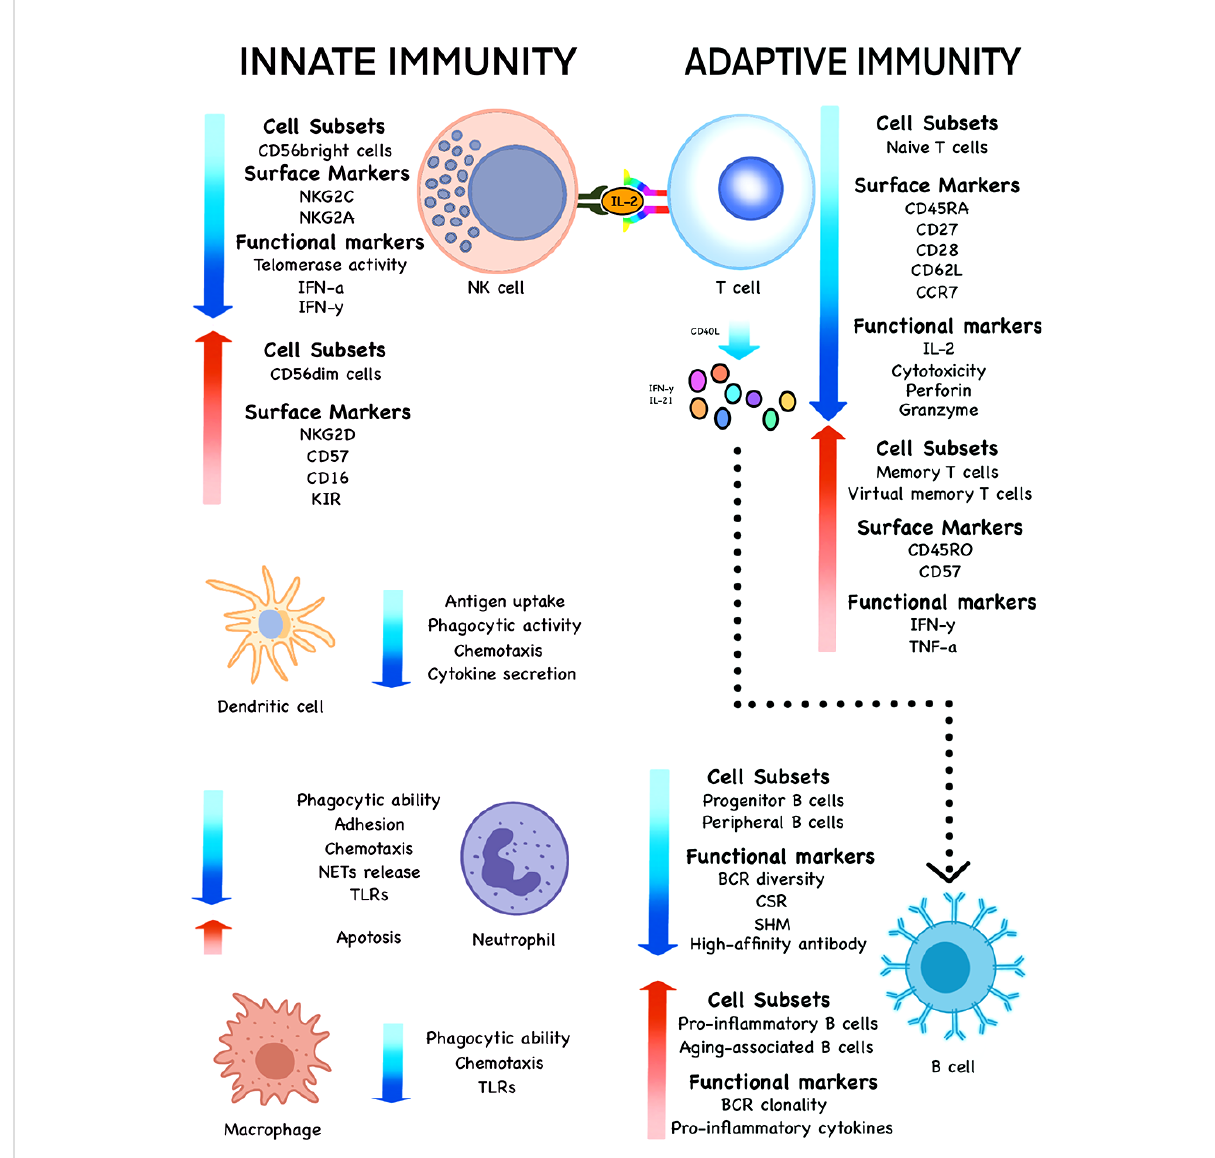
FIGURE 2 Changes of various cell subsets, surface markers and functional markers during immunosenescence. The subsets, phenotypes and functions of innate immune cells, such as NK cells, DCs, neutrophils and macrophages undergo signi fi cant changes with the increase of age in the elderly. The same is true of adaptive immune cells such as T and B